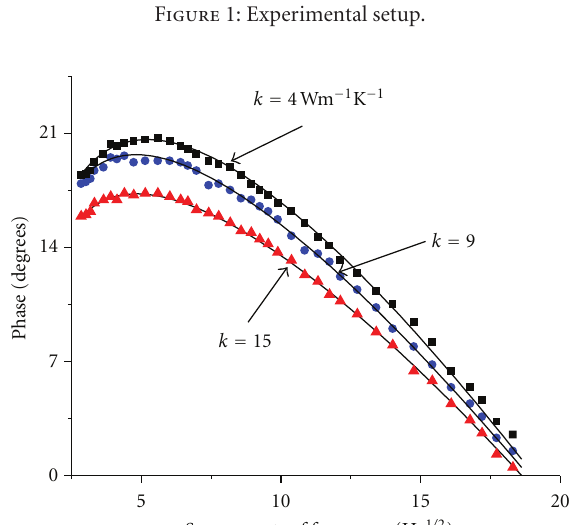
Figure 4: Amplitude of the experimental photothermal signal versus wavelength for the three In 2 S 3 samples. Table 1: Thermal properties and gap energy of three samples of In 2 S 3